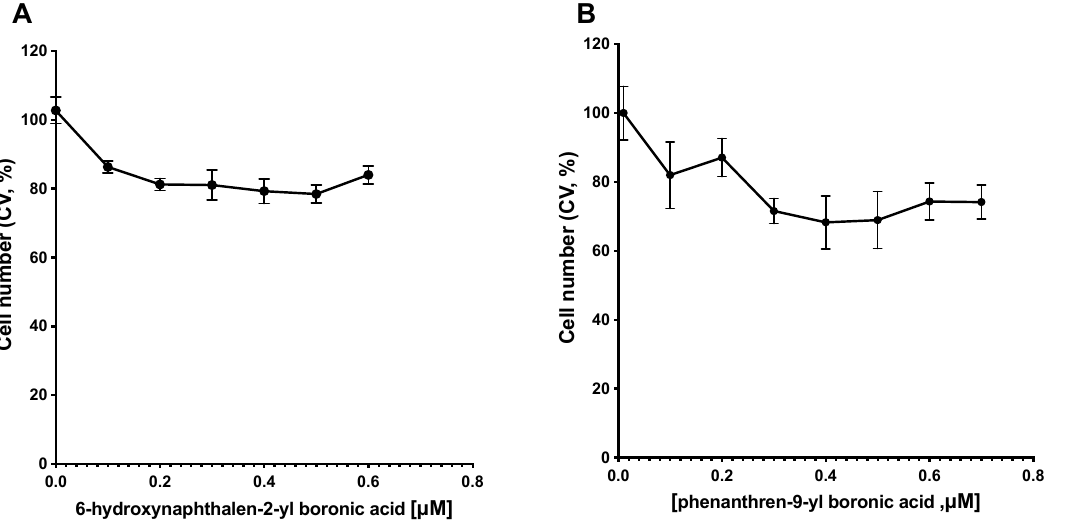
Figure 9. Toxicity evaluation in non-cancer cells. ( A ). Effects of 6-hydroxynaphthalen-2-yl boronic acid ( 1 ) on cell viability in C2C12. ( B ). Effects of phenanthren-9-yl boronic acid ( 4 ) on myoblasts in culture. Analysis was performed in triplicate. Data are presented as the mean ± SE.